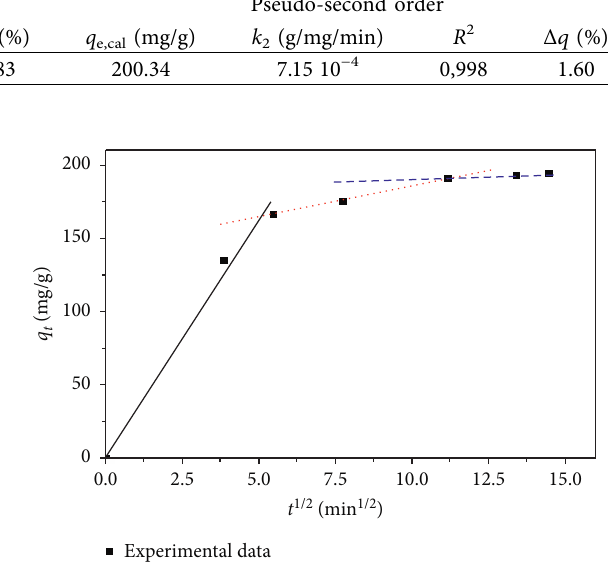
Figure 4: Plot of the intraparticle diffusion model for MO ad- sorption onto sugar scum ( C 0 � 100mg/L; adsorbent dose � 0.2g/L; pH ∼ 7; T � 20 °